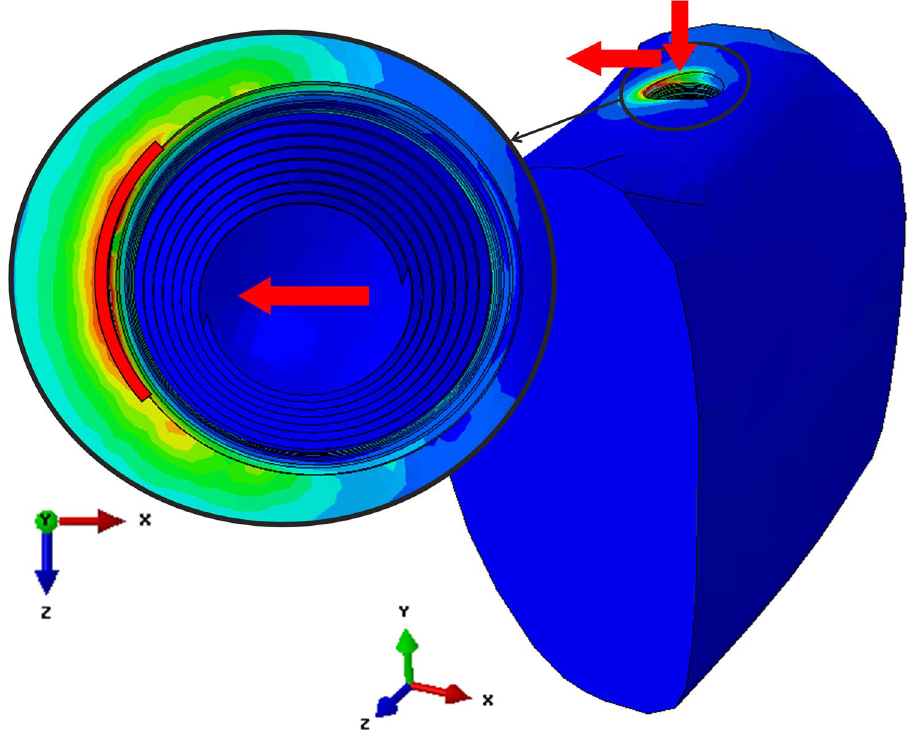
Figure 8. The critical region (marked in red) where the yield criteria were fulfilled. The arrows indicate the loading